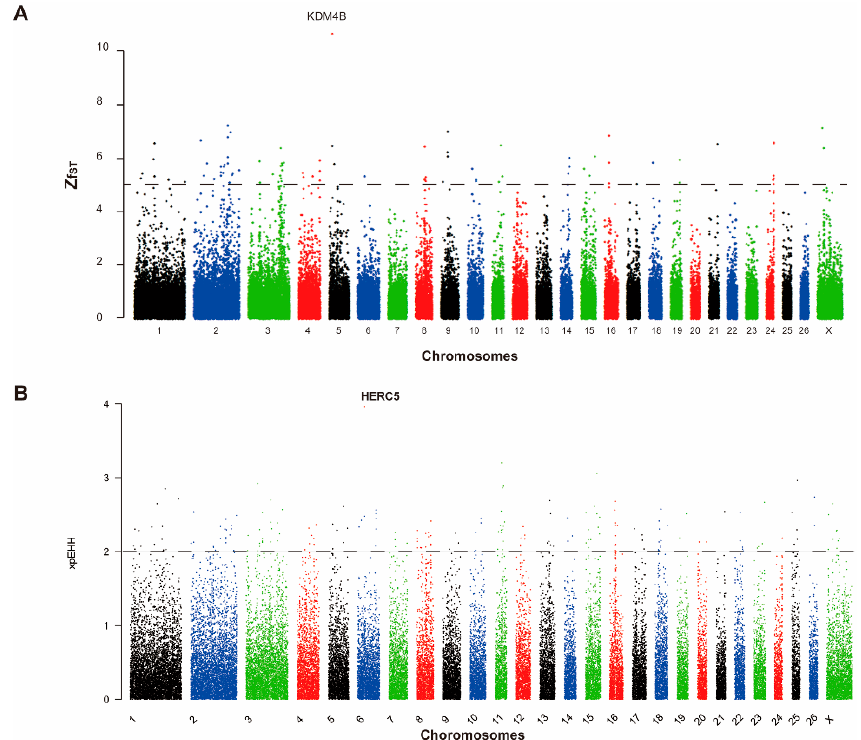
Figure 2. Selective sweep analysis of the monotocous and polytocous sheep. ( A ) Manhattan plot of FST among the monotocous and polytocous sheep. The FST was calculated for each 50 kb autosomal and X-chromosome window. The dashed line denotes a threshold of Z(FST) = 5; ( B ) Manhattan plot of XP-EHH among the monotocous and polytocous sheep. The XP-EHH value was calculated for each 50 kb autosomal and X-chromosome window. The dashed line denotes a threshold of |XP-EHH| > 2.